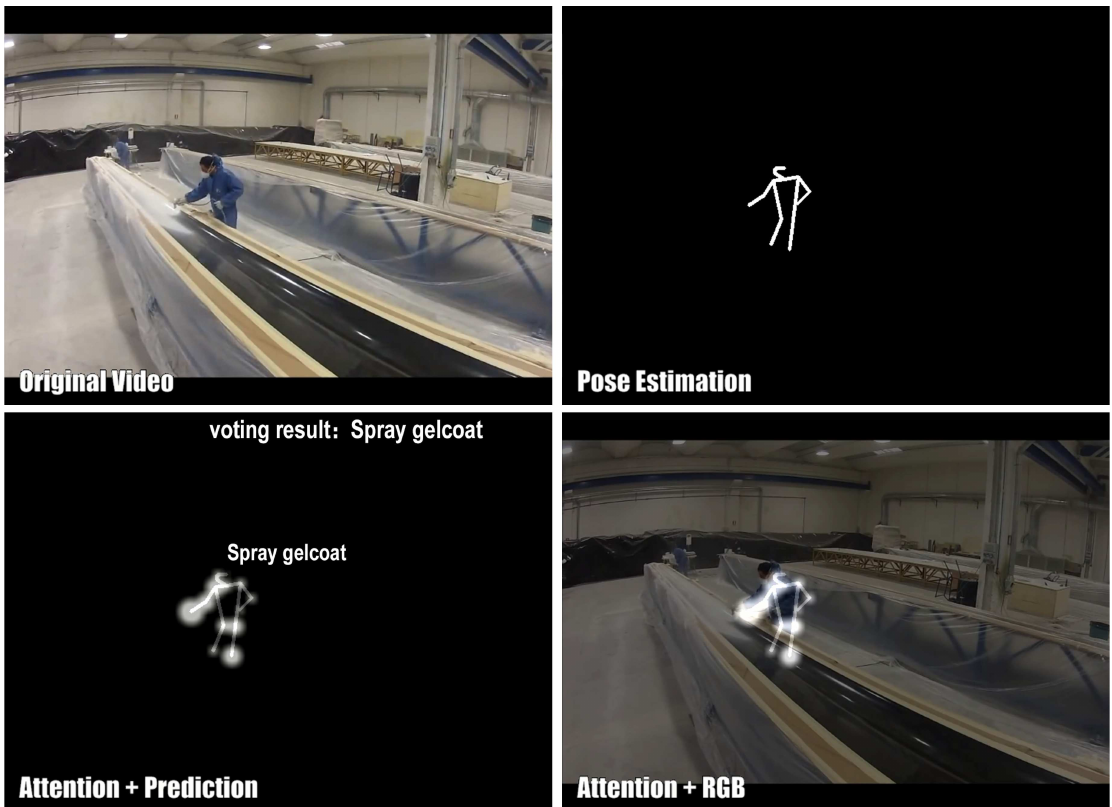
Figure 5. Visualization of the results of the method we proposed.